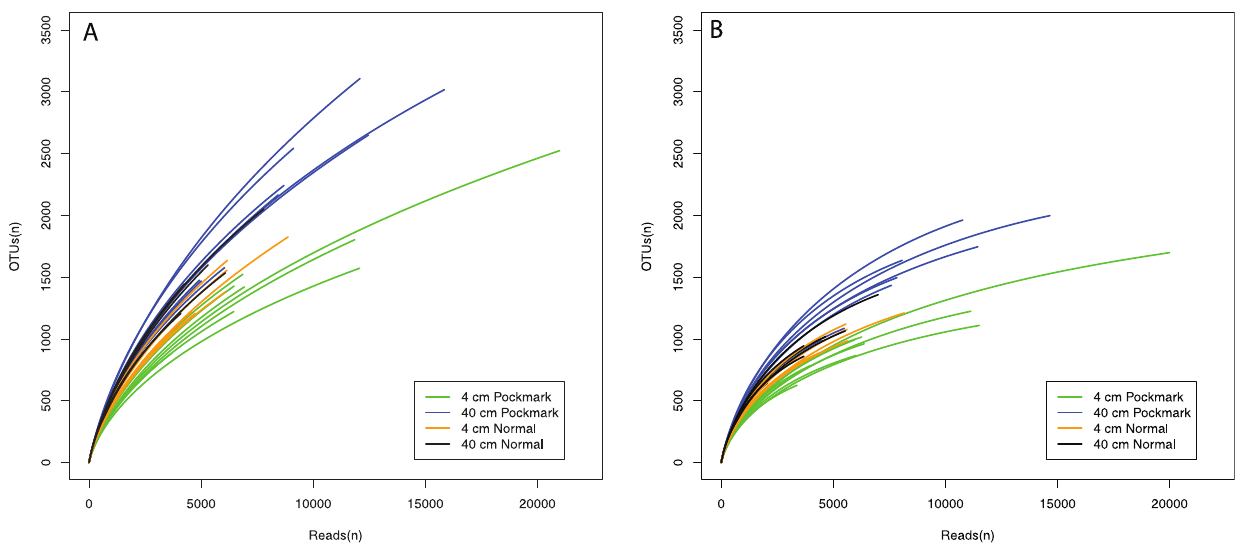
Figure 2. Rarefaction curves of 16S rRNA sequences at the 97% sequence similarity cut-off. A) Rarefaction curves with singletons included. B) Rarefaction curves with singletons excluded. The sample coloration descriptions are indicated in the figure. Samples are grouped color wise based on location (pockmark vs. reference sediments) and depth (4 cm vs. 40 cm).